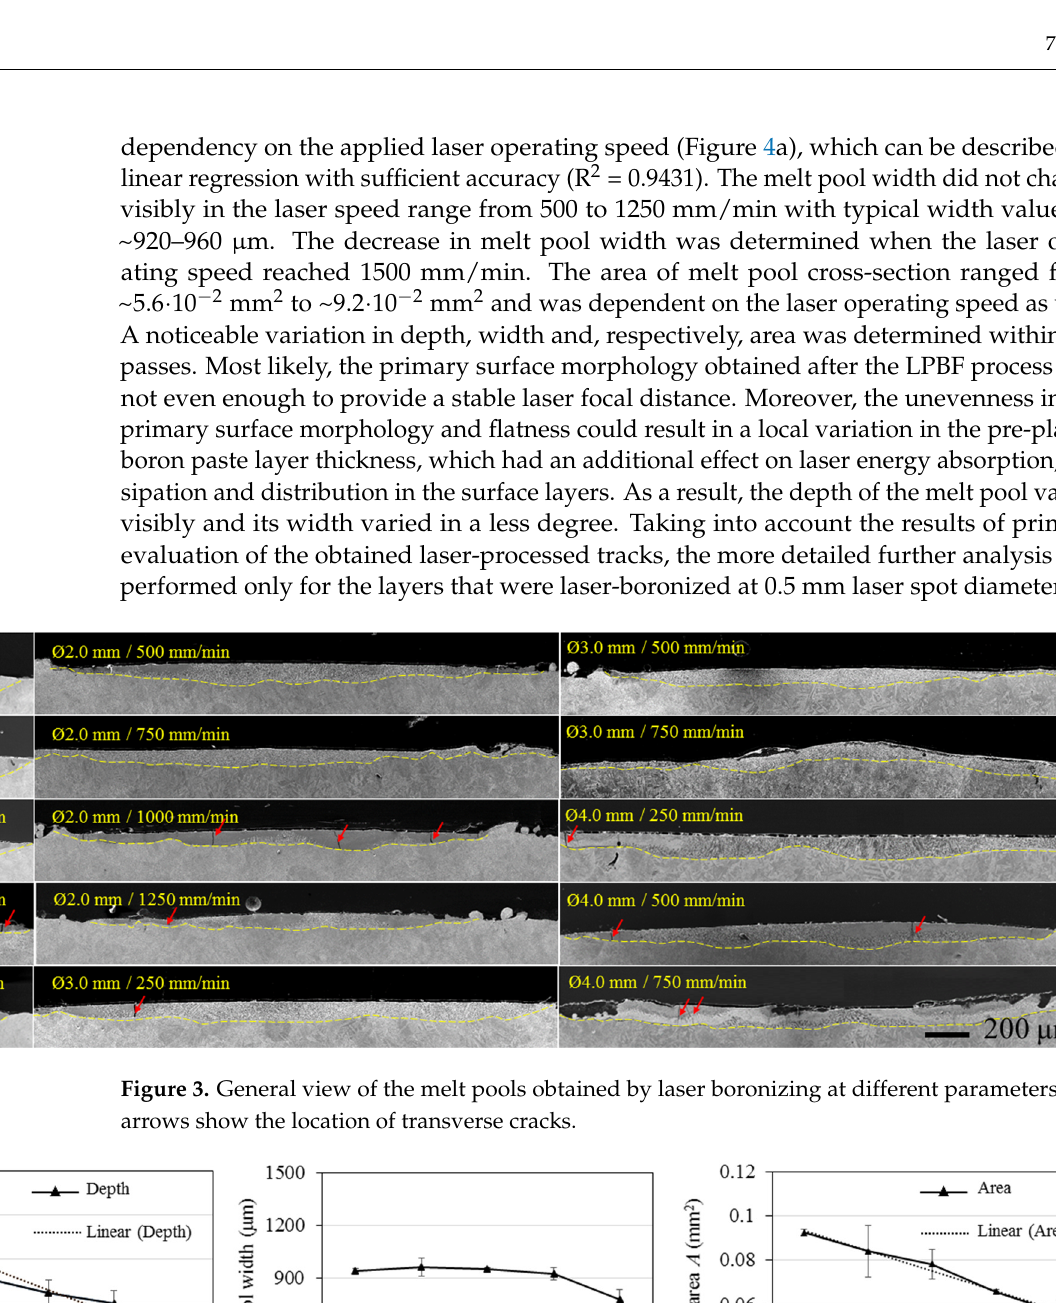
Figure 3. General view of the melt pools obtained by laser boronizing at different parameters; red arrows show the location of transverse cracks.